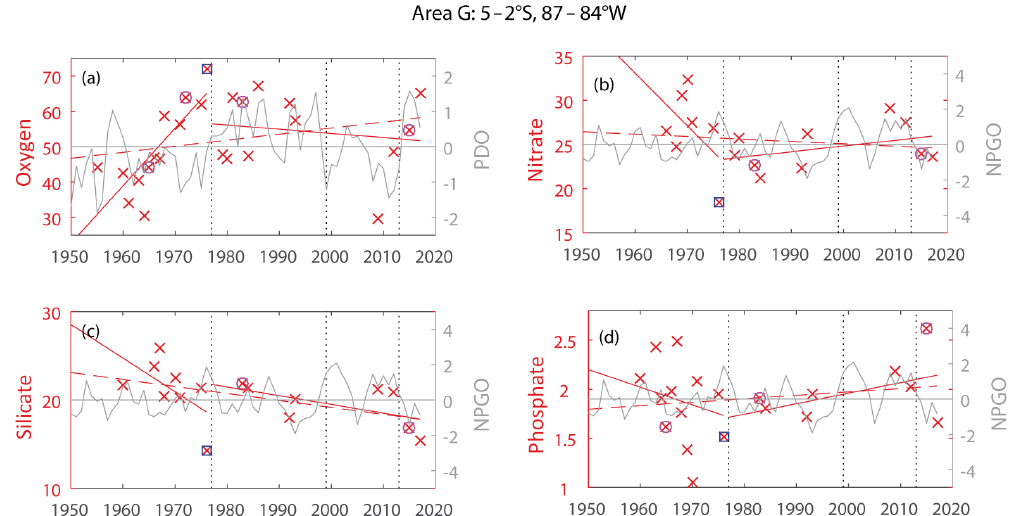
Figure 4. Annual mean concentration (µmolkg − 1 , red crosses) for years available (see Table 1) and trends for the layer from 50 to 300m plotted for the entire time period (dashed red lines) and for the periods 1950 to 1976 for the negative PDO phase and after 1976 for the positive PDO phase (solid red lines) between 2 and 5 ◦ S, 84 and 87 ◦ W (area G) µmolkg − 1 yr − 1 for oxygen, nitrate, silicate and phosphate. El Niño years defined as strong or very strong are marked by an additional magenta circle and strong La Niña years by an additional blue square. For oxygen, measurements in 1982 were removed as the 50–300m mean was much too high (104.8µmolkg − 1 ), and for nitrate, measurements in 1967 which were too high (36.8µmolkg − 1 ) were removed. The changes of the PDO status in 1977, 1999 and 2013 are marked by vertical dotted lines. The annual mean PDO index is shown in the oxygen time series as a grey curve and the NPGO index is shown in the nitrate, silicate and phosphate time series as a grey curve.